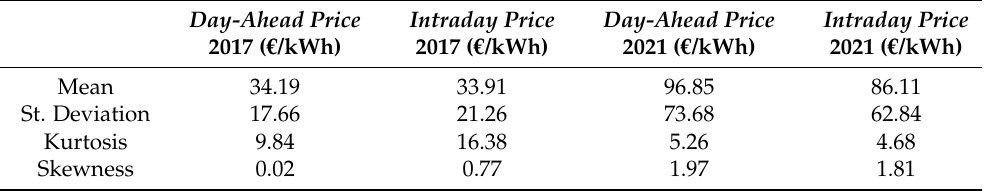
Table 1. Descriptive statistics of wholesale electricity prices in the German power market ( €